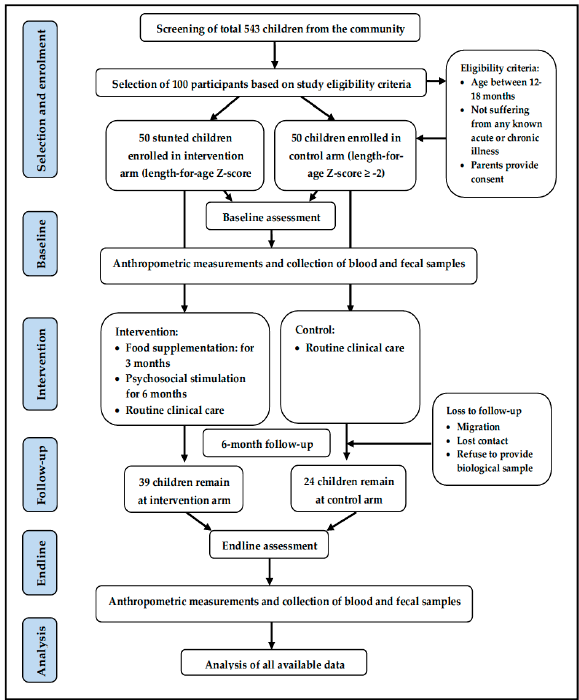
Figure 1. Cohorts, participants, and analyses flow chart.